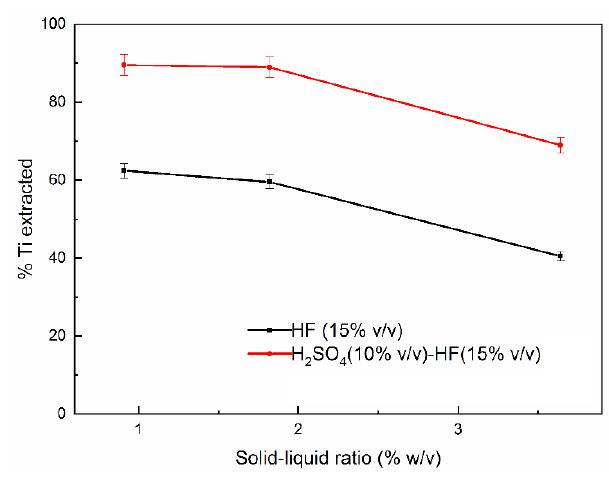
Figure 7. E ff ect of solid–liquid ratio. Figure 7. Effect of solid–liquid ratio.